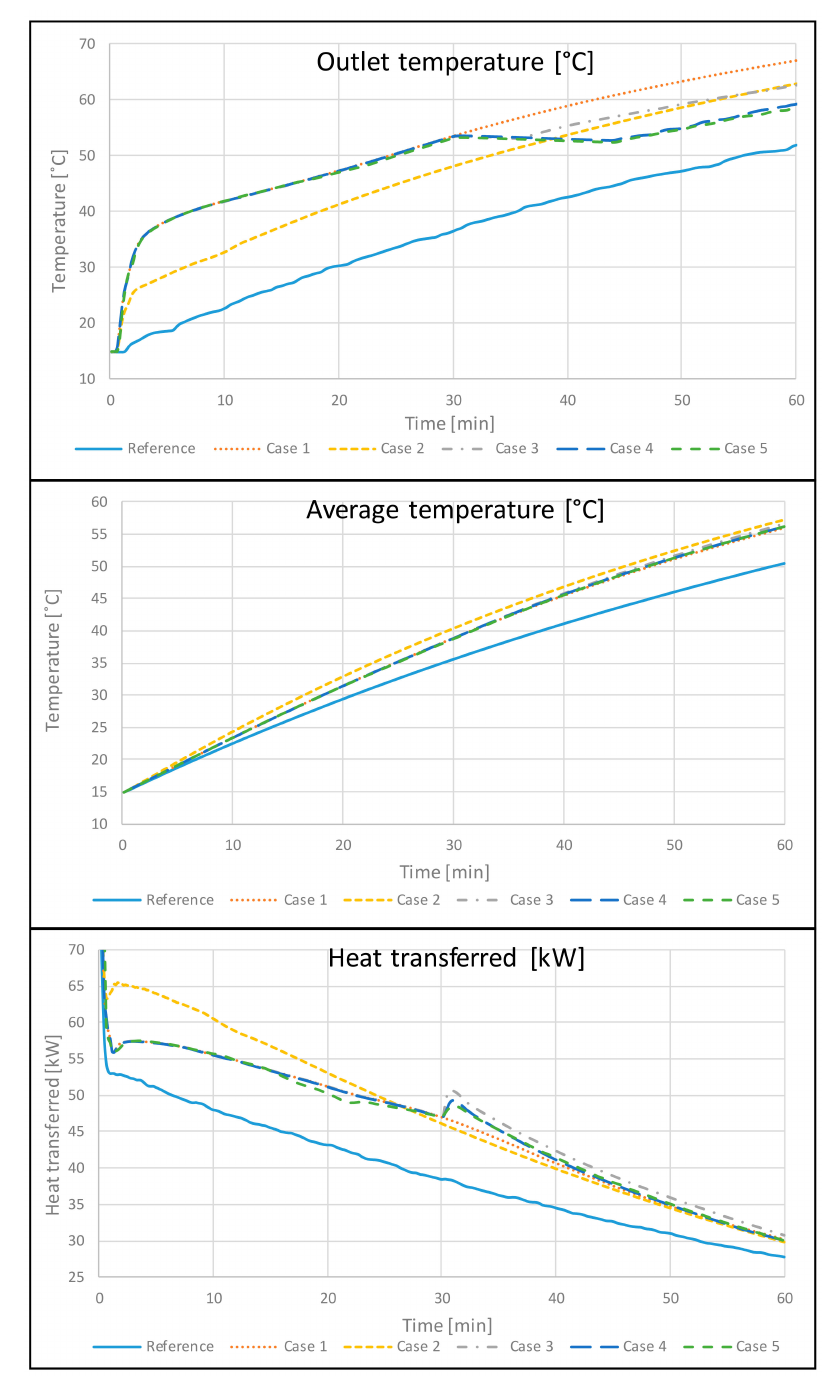
Figure 12. Comparison of outlet DHW temperatures, average temperatures and heat exchanged in the entire